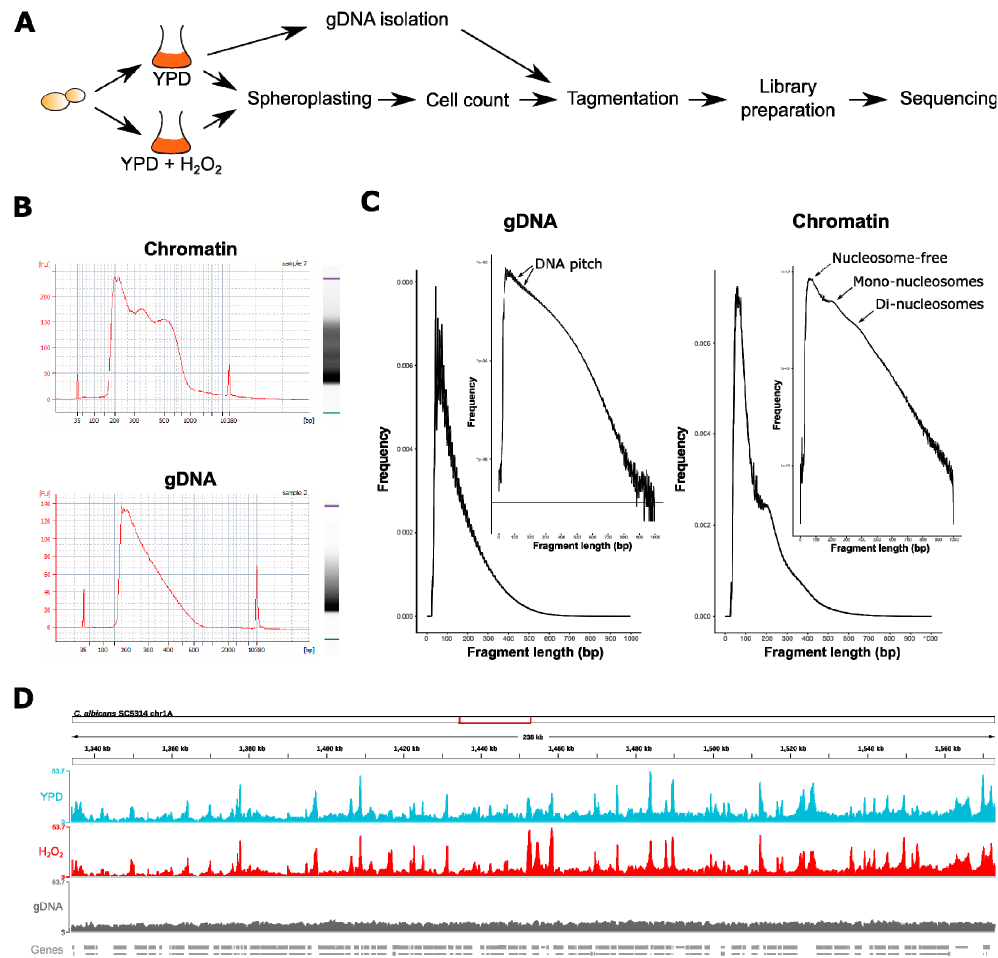
Figure 1. Quality control of assay for transposase-accessible chromatin using sequencing (ATAC-seq) libraries from Candida albicans treated or non-treated with H 2 O 2 . ( A ) Experimental set-up for ATAC-seq profiling of 5 × 10 6 C. albicans (see Materials and Methods for details). ( B ) Bioanalyzer electrophoretic profiles and gel image from ATAC-seq libraries prepared from fungal chromatin (isolated nuclei) or naked gDNA. The x-axis from the electropherogram depicts the fragment size distribution (bp) of tagmented samples and the y-axis represents the abundance. A distinct nucleosomal pattern (mono-, di-, and tri-nucleosomes) is visible in chromatin samples, but not in tagmented gDNA samples. ( C ) Fragment length distribution of ATAC-seq reads from gDNA and nuclei prepared from YPD (1% yeast extract, 2% peptone, 2% glucose)-grown cells. The fragment length in bp (x-axis) from one representative biological replicate from each group is plotted against its frequency (y-axis). The graph insert shows the log-transformed histogram. Signals originating from the DNA helical pitch [31] are emphasized by arrows on the gDNA plot. Arrows on the chromatin plot indicate nucleosome-free ATAC-seq read fragments and nucleosome occupied read fragments. ( D ) Integrative Genomics Viewer (IGV) browser snap-shot from a 238 kb region of the C. albicans chromosome 1A of ATAC-seq reads from aligned BAM files. The biological replicates from each sample group were pooled. Genes are depicted as gray boxes below the sequencing read coverage tracks.